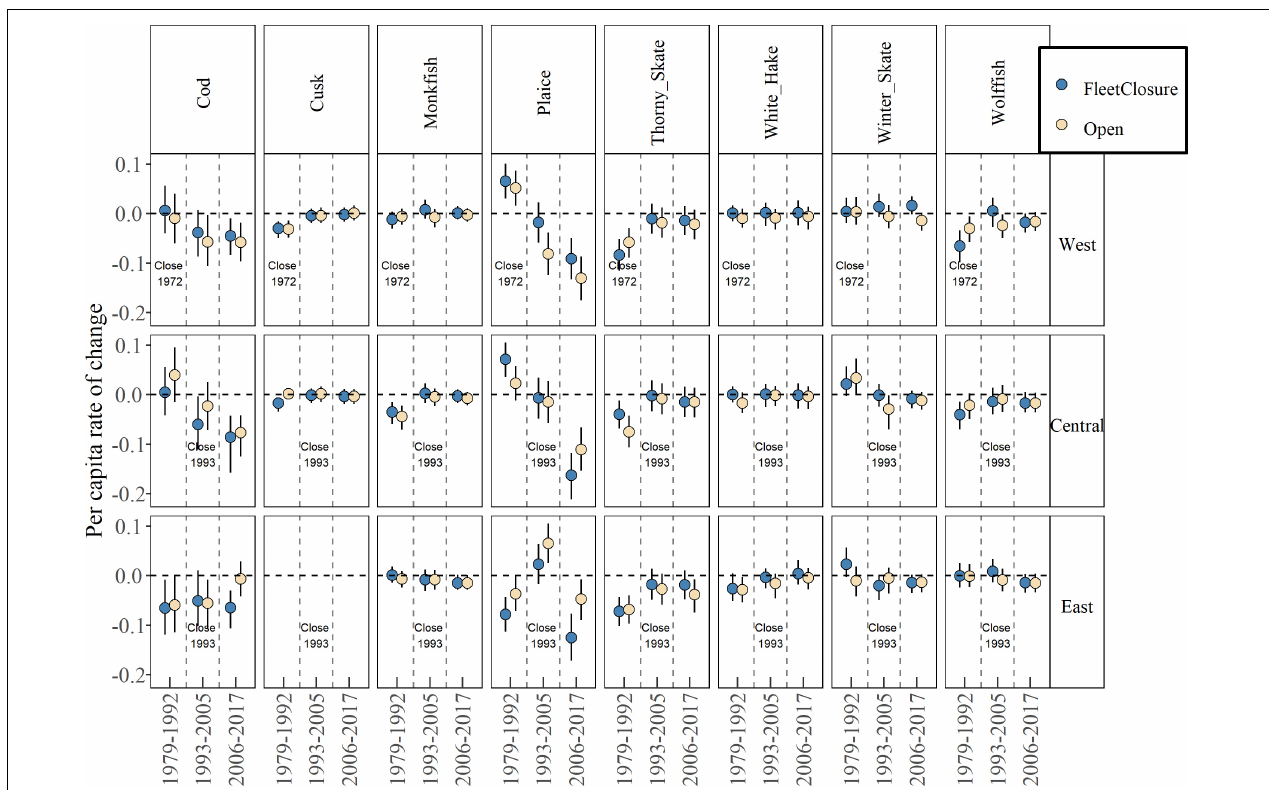
FIGURE 5 | Median estimate and 80% credible intervals of per capita rate of change for eight severely depleted species in fleet-closed and open areas in three periods. See Supplementary Figure 4 for all species and Table 1 for species full